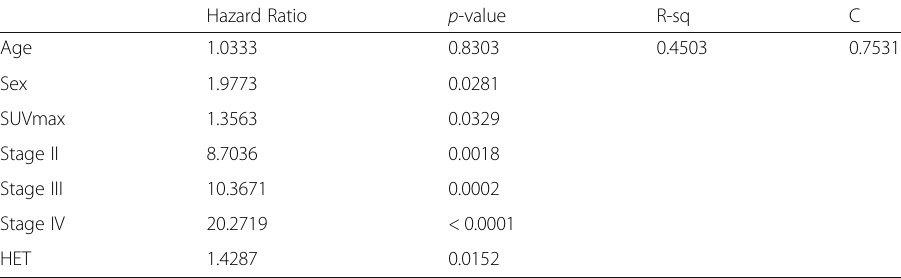
Table 2 Multivariate